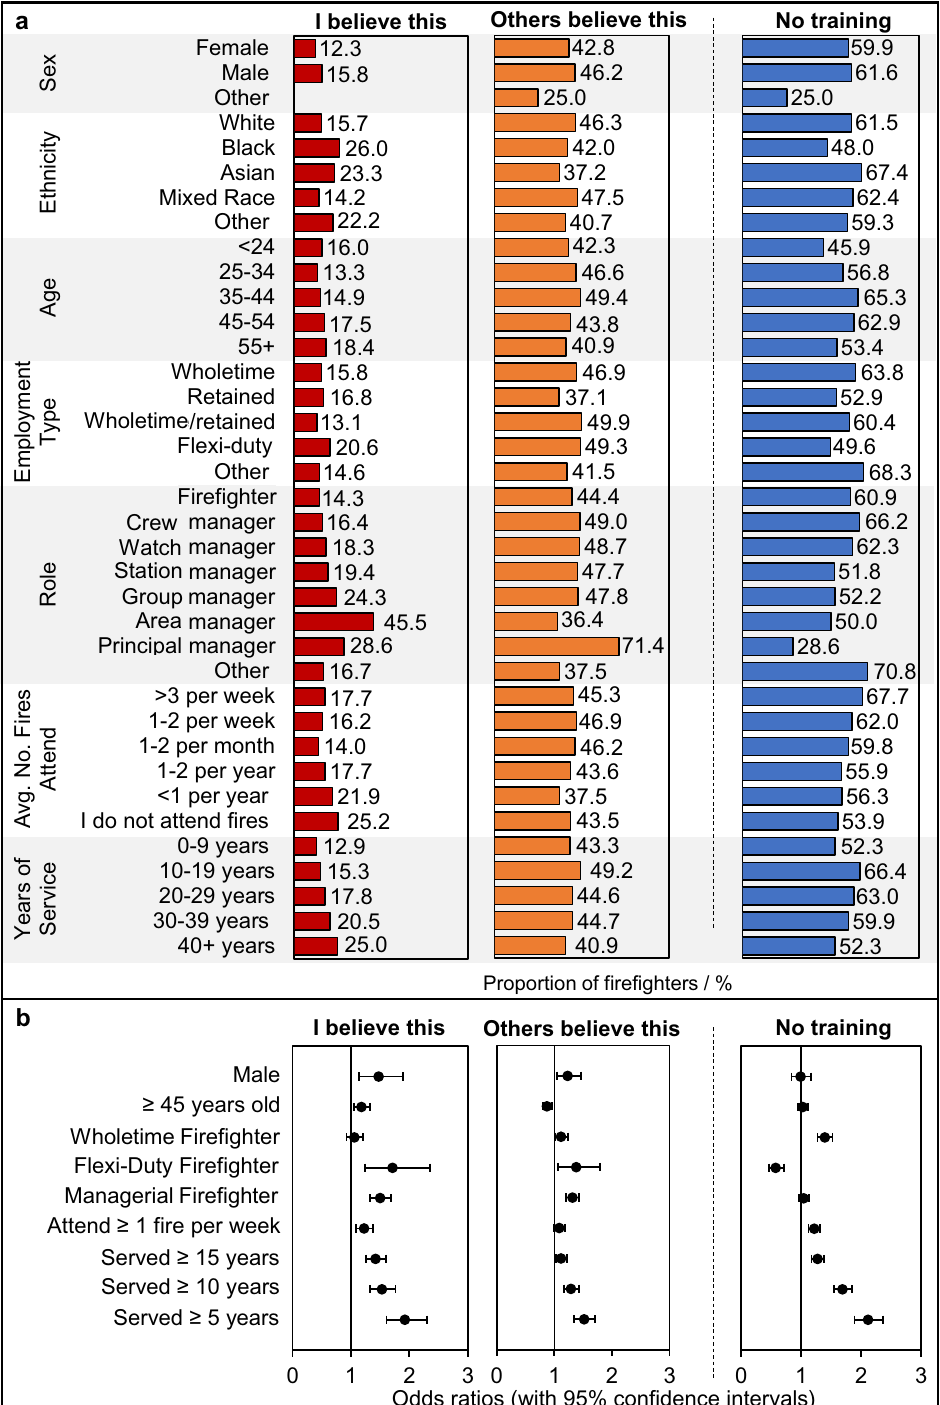
3 Odds ratios (with 95% confidence intervals) Figure 2. Firefighter demographics and belief in the BoH, and training on fire contaminants and their associated health outcomes . ( A ) The proportion of total surveyed firefighters in each demographic category who personally believe in the BoH, who feel others believe in the BoH, and who have not received any training on the health effects of smoke/contaminant exposure. ( B ) Crude odds ratios (with 95% confidence intervals) for belief in the BoH attitude/lack of training and demographics. Note that the small sample size for certain demographic groups (e.g. sex = Other, where n = 4), mean that the above proportions should be interpreted cautiously. Participant demographics are summarised in Wolffe et al. 10